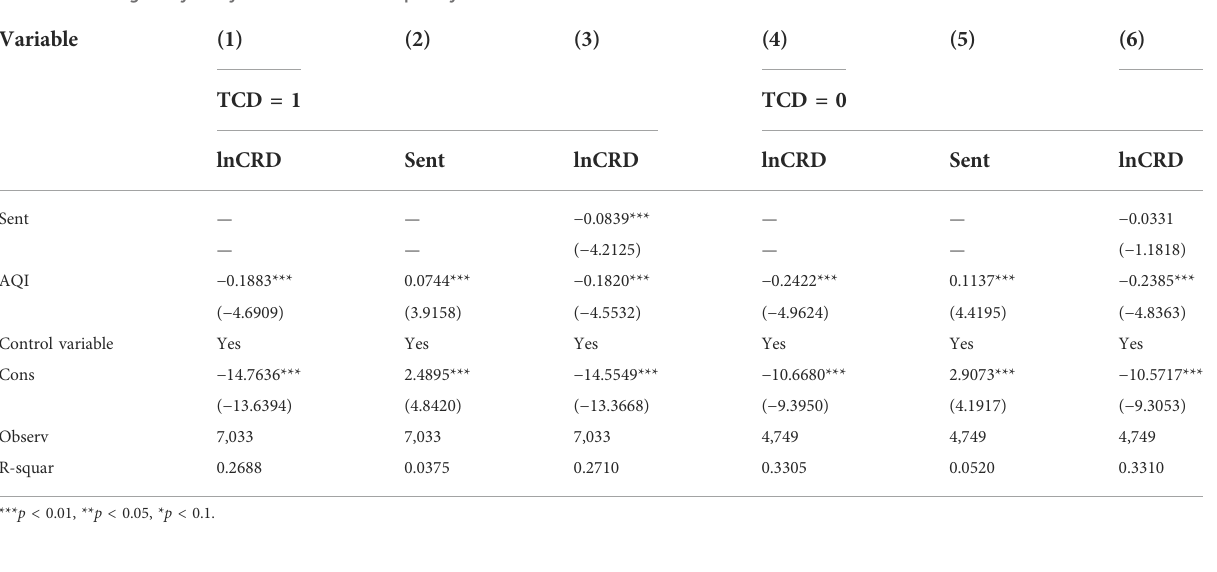
TABLE 6 Heterogeneity analysis of technical complexity based on investor sentiment. Variable